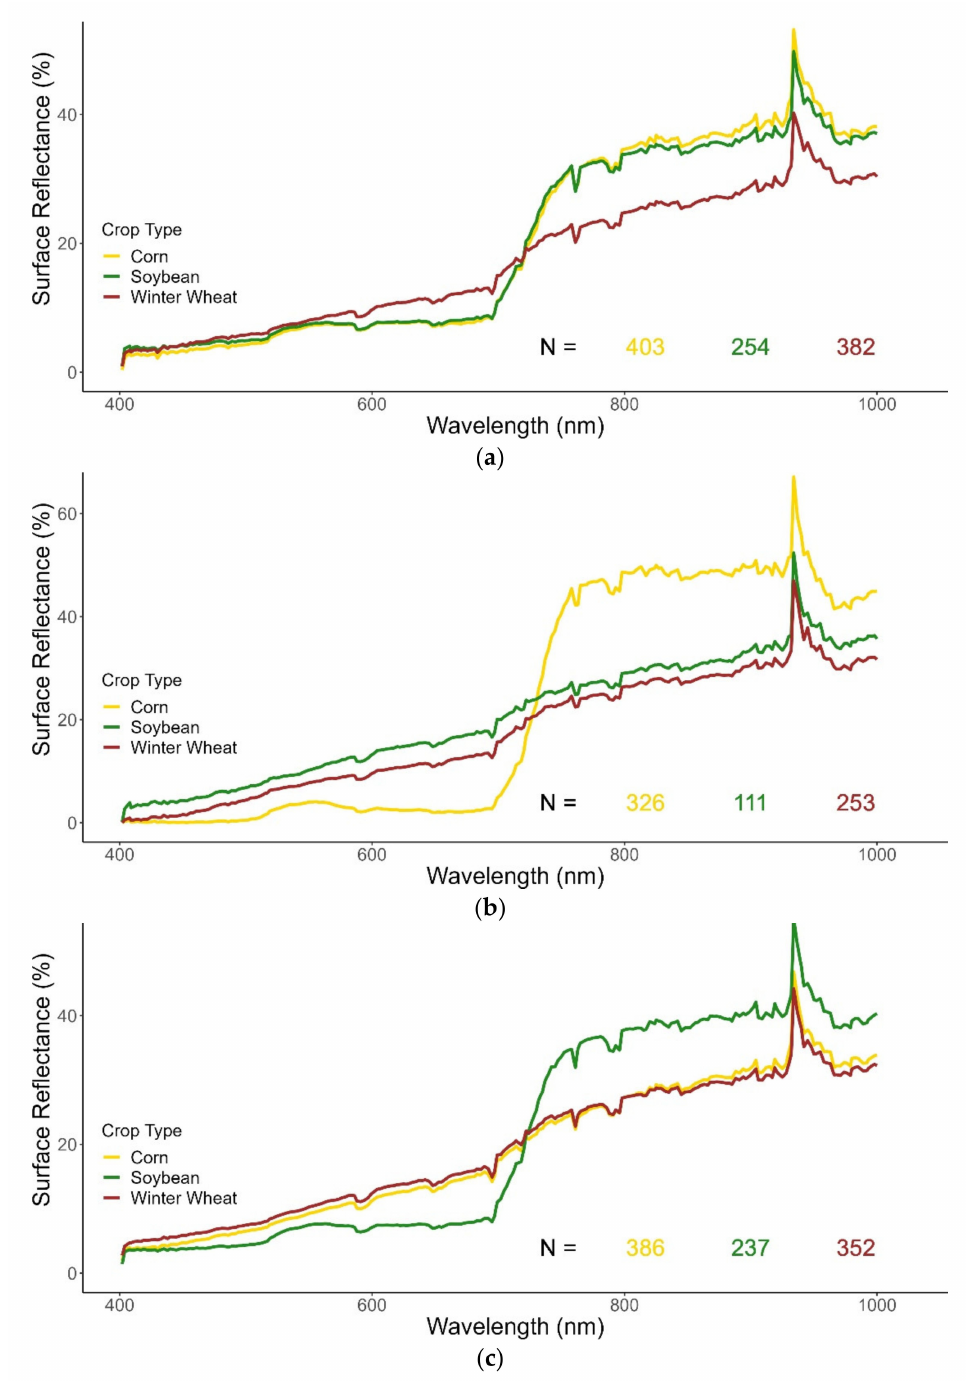
Figure 6. Average DESIS 2019 (wet year) spectra by crop type for: ( a ) June (Julian Day 172), ( b ) July (Julian Day 208), and ( c ) August (Julian Day 223). N is number of spectra included in the